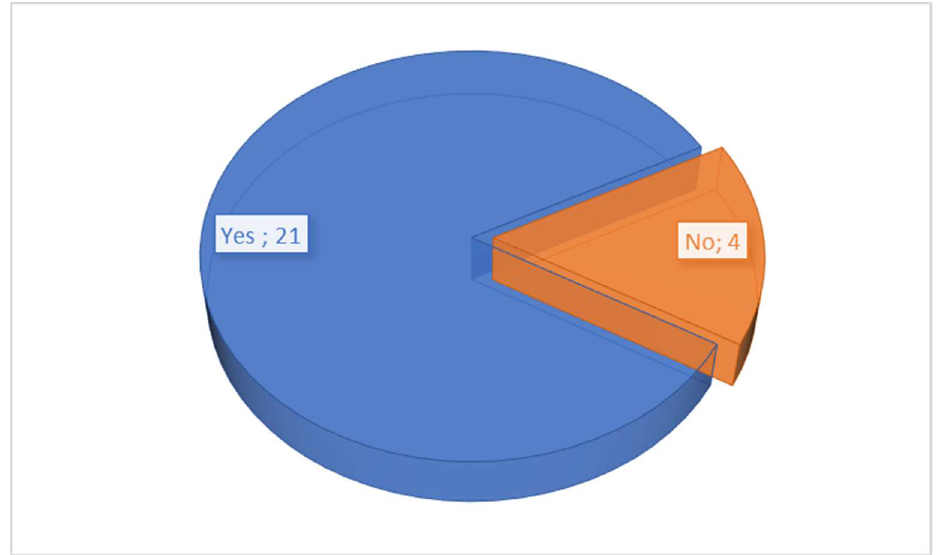
Figure 7. Companies with the possibility of expressing opinions by users.